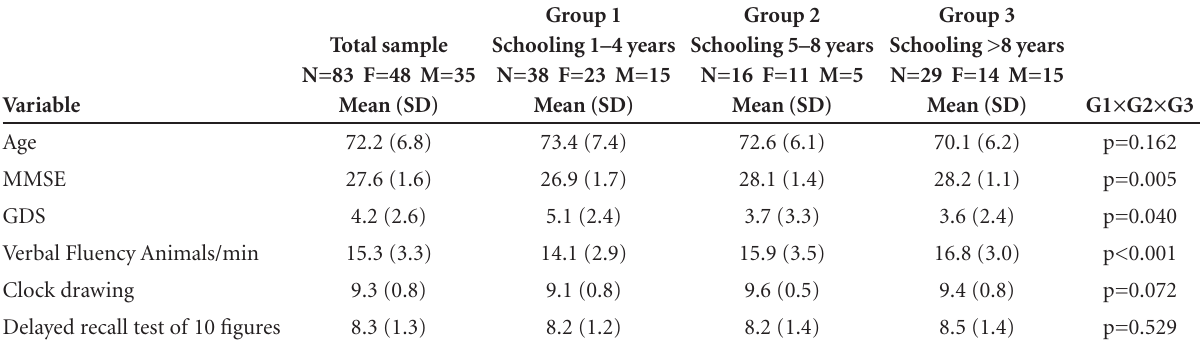
Table 1. Main sociodemographic characteristics and results of the cognitive tests: total sample, Groups 1, 2 and 3.